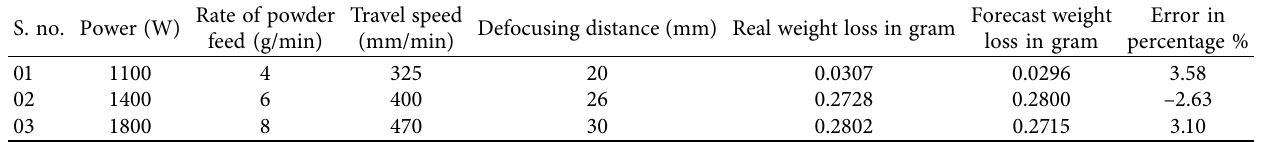
Table 8: Confirmation test